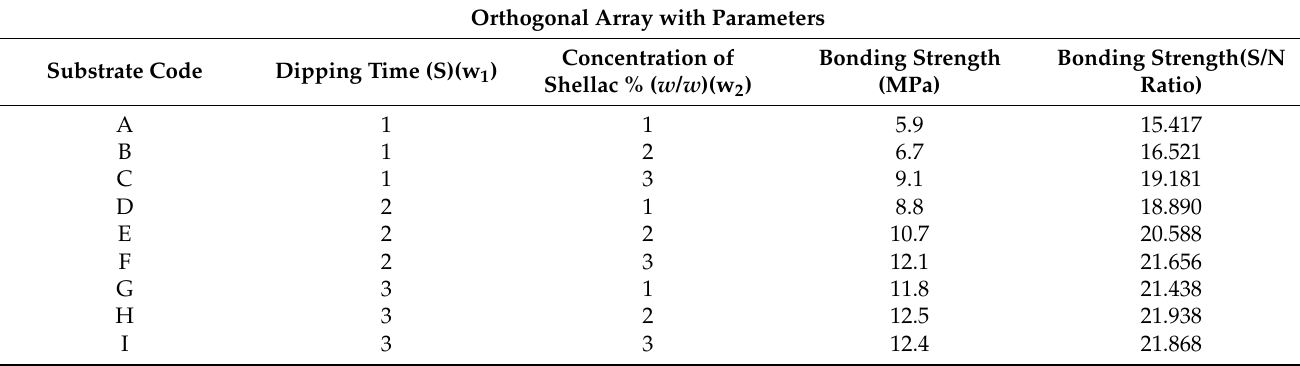
Table 4. Measured experimental values with S/N ratio.